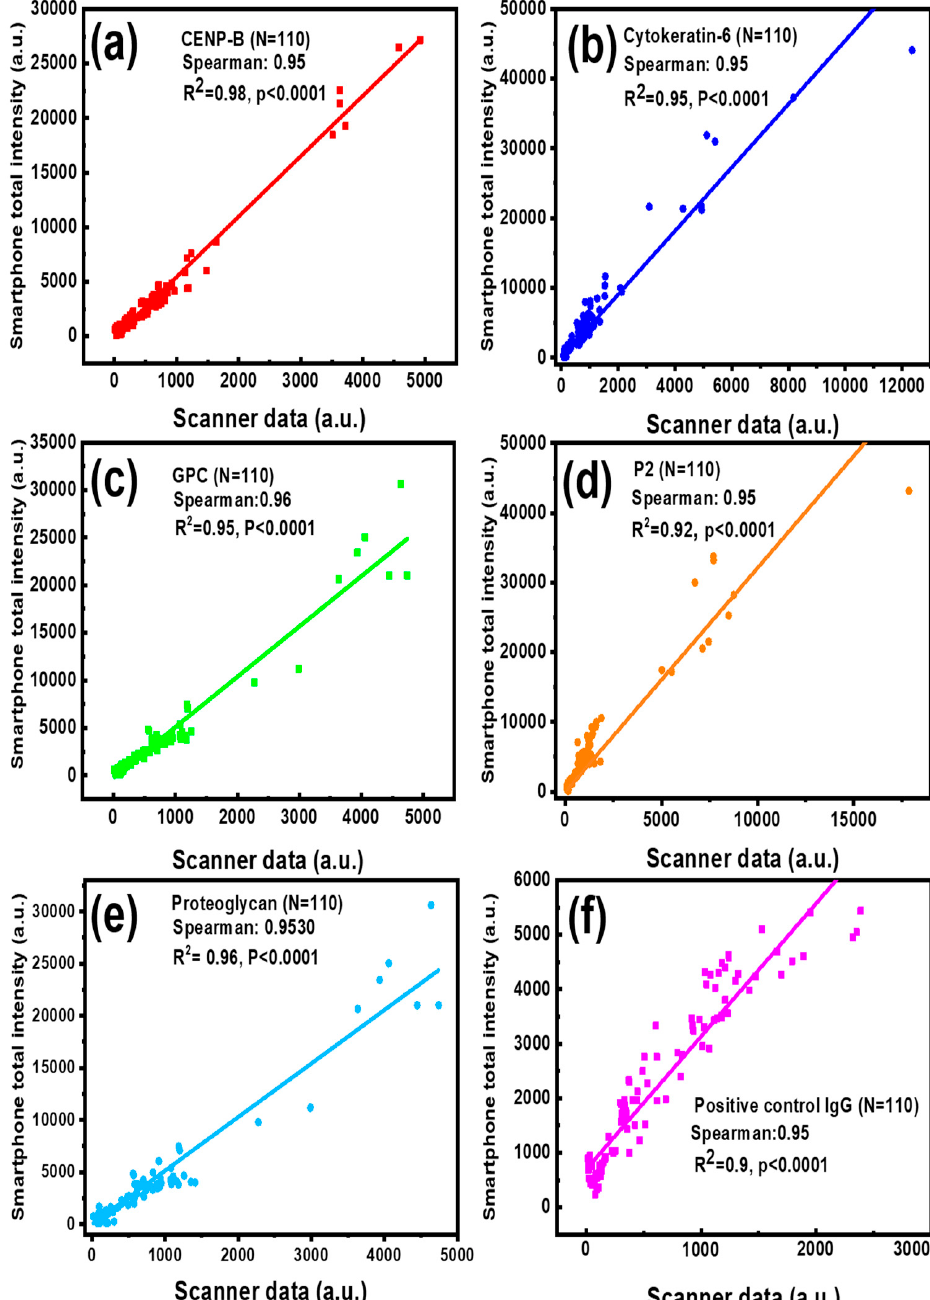
Figure 5. Correlation between the reference data measured by the lab scanner GenePix Pro 7 program and the data obtained by the smartphone application when detecting lupus serum biomarkers: CENP-B ( a ), Cytokeratin-6 autoantibody ( b ), GPC ( c ), P2 autoantibody ( d ), Proteoglycan autoantibody ( e ) and positive control IgG ( f ).